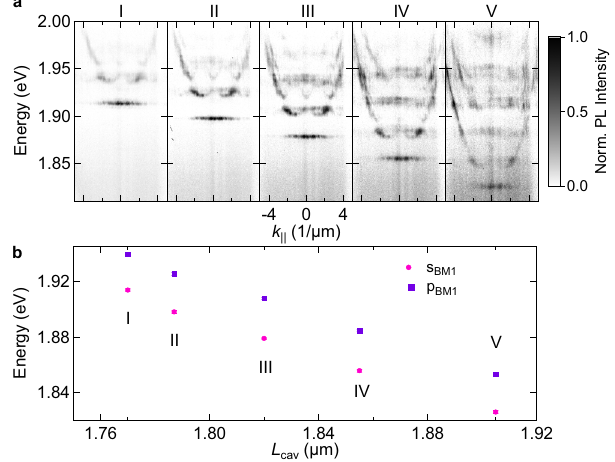
Fig. 3 Widely tunable lattice polaritons. a Momentum-resolved PL spectra of the 1D linear chain with a lens diameter of D = 5 µ m and an overlap D/A = 1.7 for increasing DBR separations from left to right. The PL emission arises as a result of the coupling between the photonic lattice and the WS 2 excitons. The pump power is ~ 227 µ W and an integration time of 480 is used for each individual spectrum. The PL map intensities are coded in a false colour scale included on the right side of the panels. b Dependence of the s- (magenta circles) and p-band (violet squares) energy versus cavity length L cav . The energy was tuned over 87.8 meV (s-band) 86.3 meV (p- band) with a change of the DBR separation by 135 nm. The error bars in ( b ) represent the accuracy in the energy